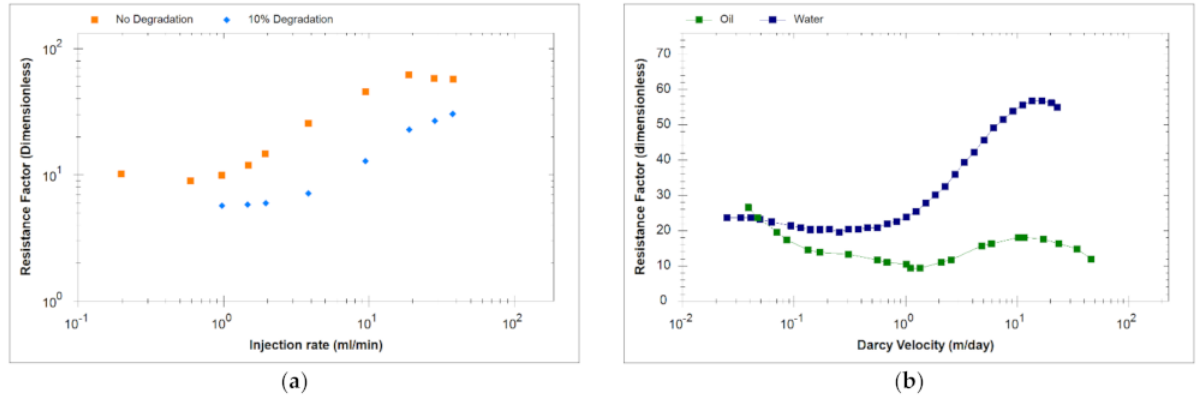
Figure 4. ( a ) Impact of degradation from pre-shearing and ( b ) Oil presence, on the onset of SAV-10 apparent shear thickening in porous media (Modified from